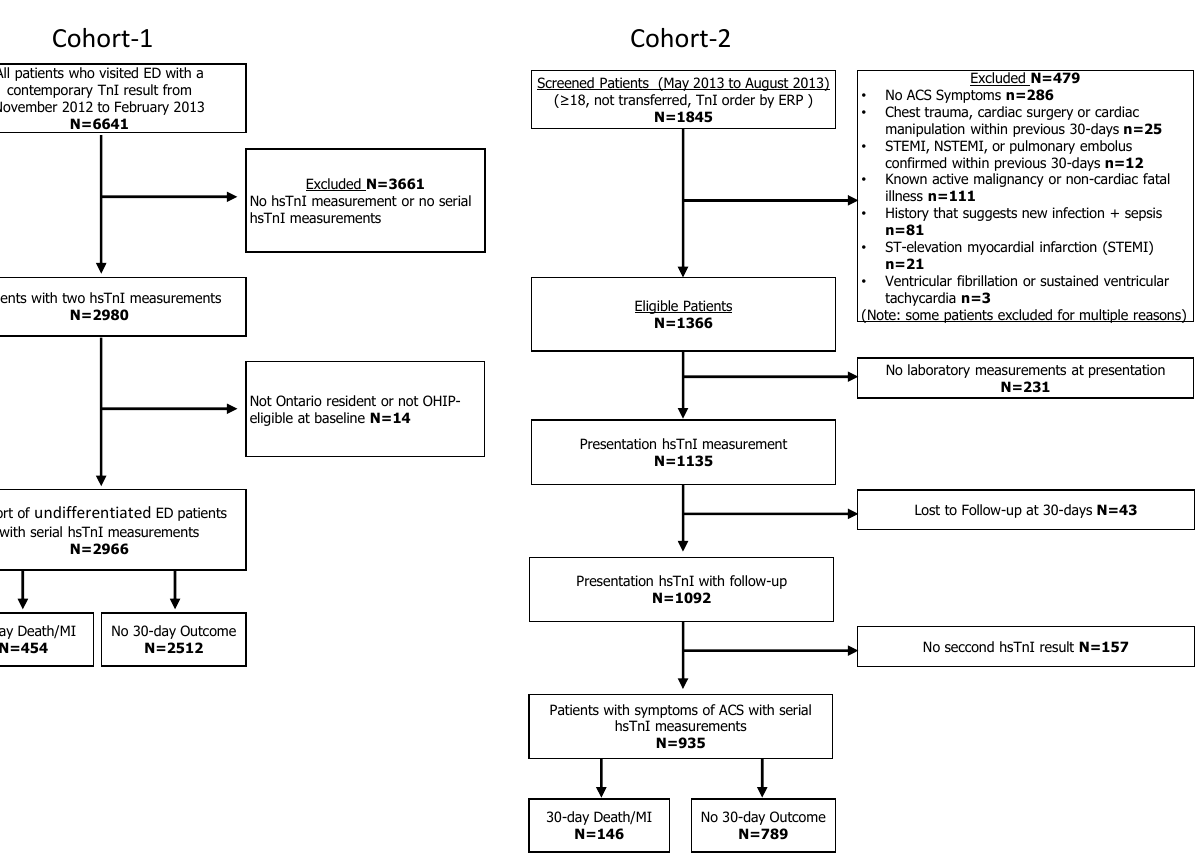
Figure 1. Flow diagram of the two cohorts.